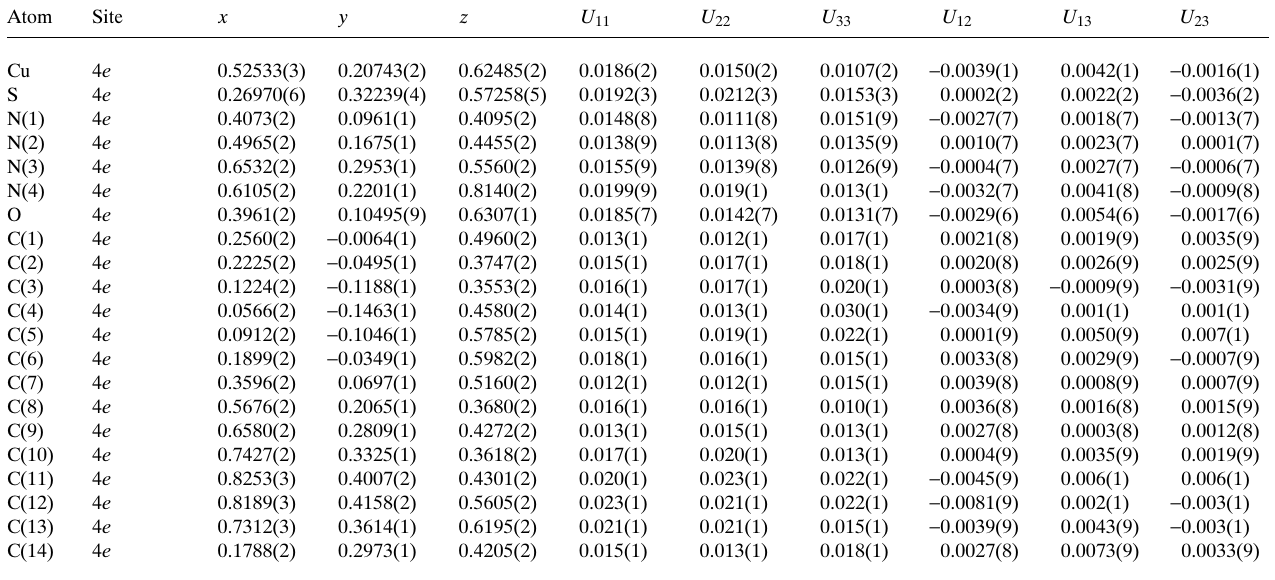
Table 3. Atomic coordinates and displacement parameters (in Å 2 ) .